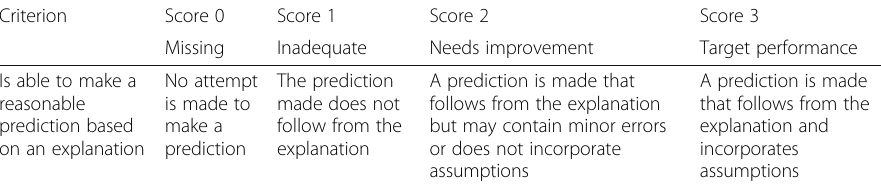
Table 1 Sample rubric item Criterion